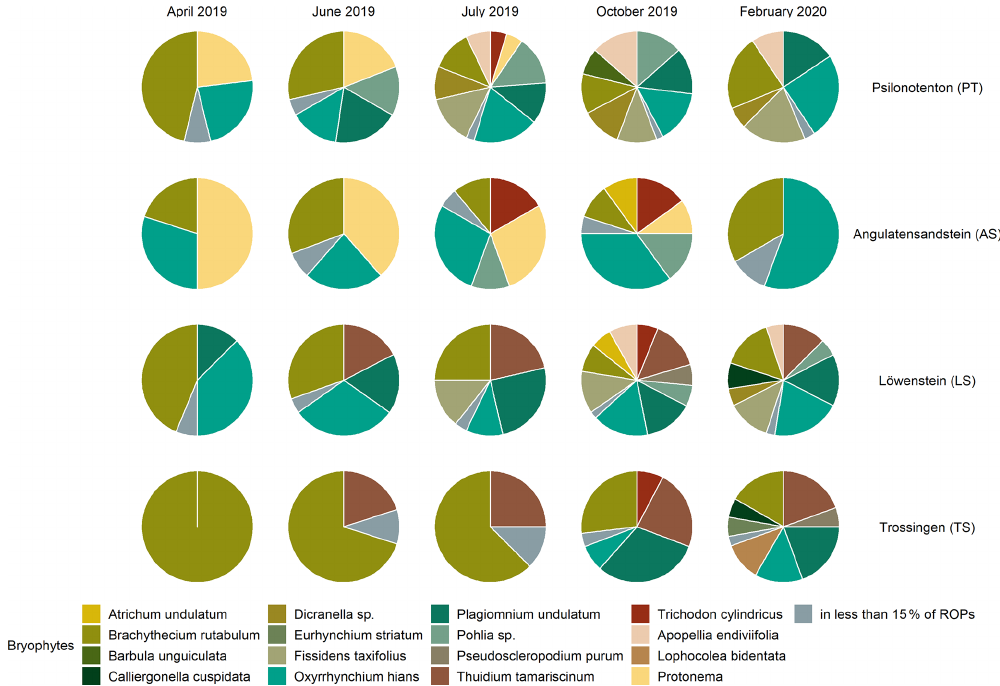
Figure 1. Bryophyte species composition in the different skid trails for each time of vegetation survey. Species from the same genera are grouped together, and species which occur in less than 15% of the runoff plots are listed in one